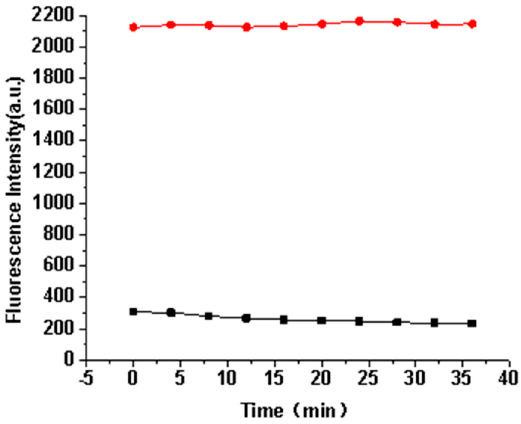
Figure 4. Time-dependent normalized fluorescence changes of QCy (1.0 µ M) with Ag + (5.0 µ M) ( black ) Figure 4. Time ‐ dependent normalized fluorescence changes of QCy (1.0 μ M) with Ag + (5.0 μ M) and without ( red ) at 760 nm in EtOH/PBS (1:9 v / v , pH = 7.0, 10 ( black ) and without ( red ) at 760 nm in EtOH/PBS (1:9 v/v, pH = 7.0, 10 mM).